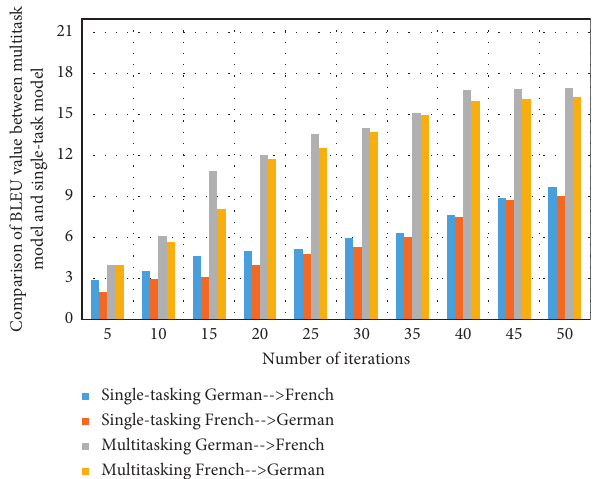
Figure 6: Comparison of the two models on the German < -- > French translation task.